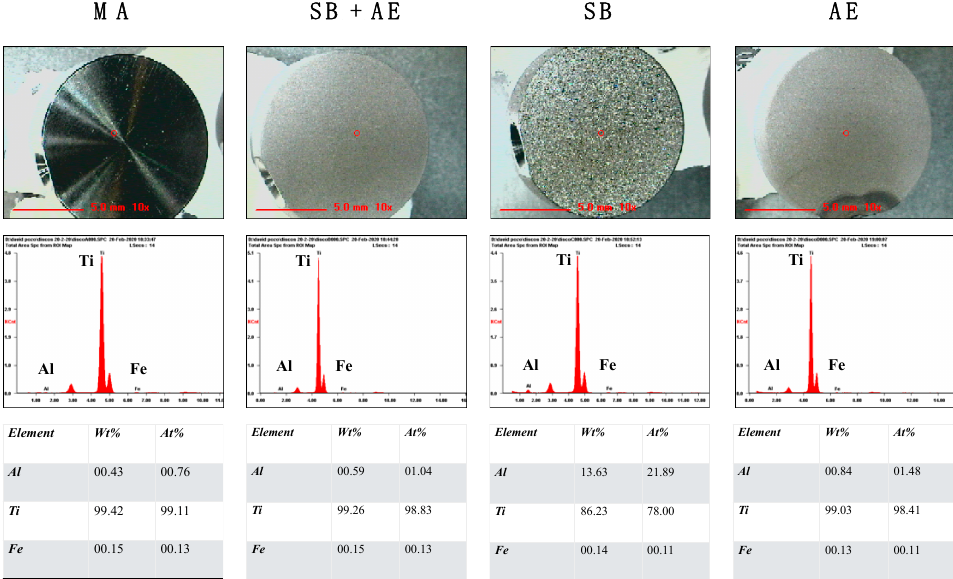
Figure 1. Composition of the different titanium discs by XR microfluorescence. The surface treatments were: mechanical abrasion (MA), sandblasting plus acid etching (SB + AE), sandblasting (SB) and acid etching (AE).